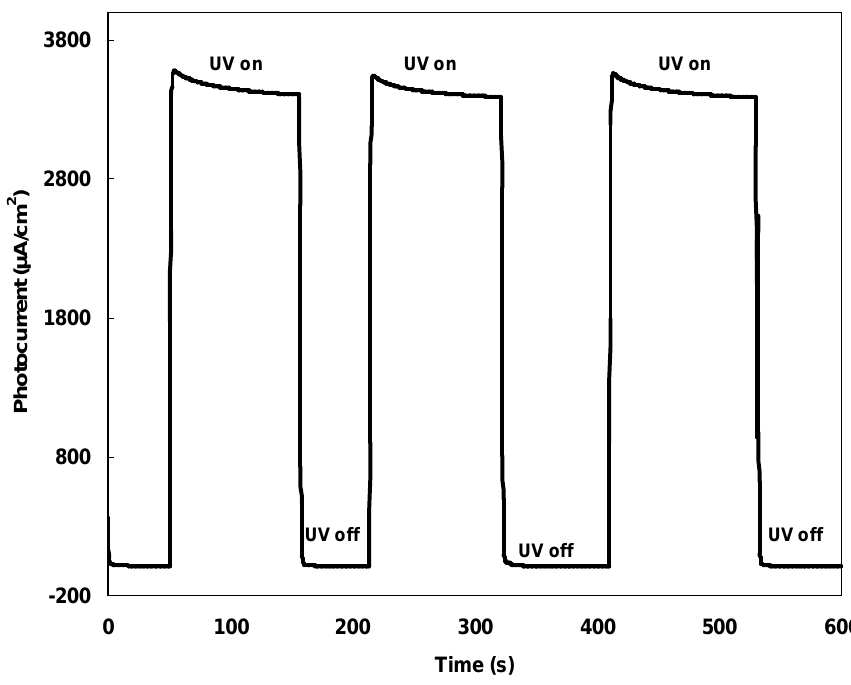
Fig. 7. Stability test for TiO